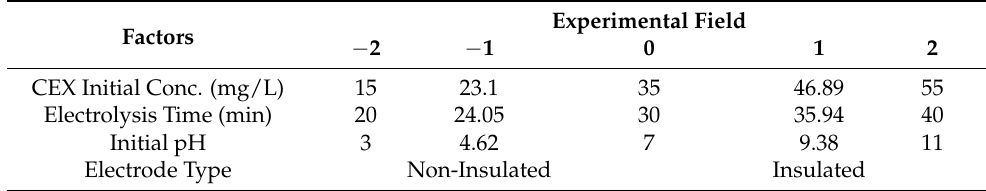
Table 1. Independent parameters and ranges based on